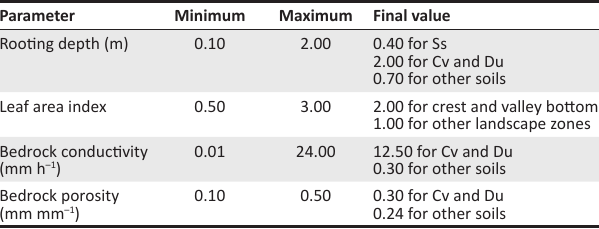
TABLE 2: Calibration ranges and final values for selected model